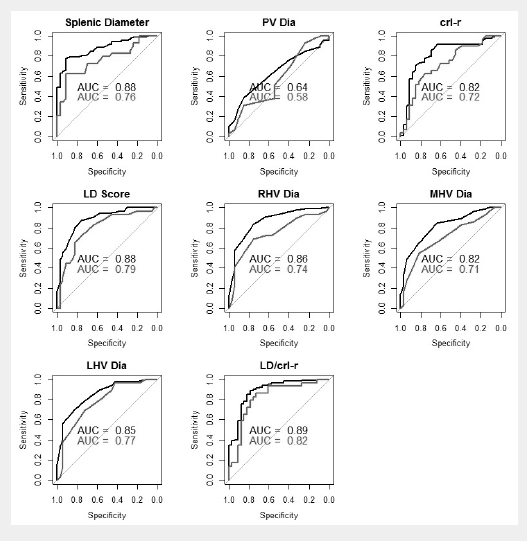
Receiver operating characteristic curves of the cirrhosis group (black) and the fibrosis group (gray) demonstrated highest AUC for ld/crl-r. AUC = area under the curve; spl dia = splenic diameter; pv dia = portal vein diameter; crl-r = caudate-right lobe ratio; ld score = sum of liver veins diameter; rhv dia, mhv dia, lhv dia = right, middle and left hepatic vein diameters; ld/crl-r = ld score divided by